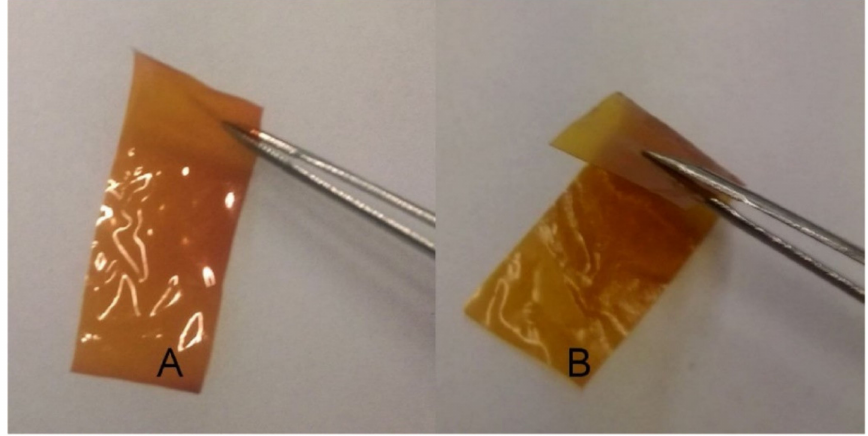
Figure 10. ( A ) HYH–Ag and ( B ) HYH–Ag–lecithin foils. Reproduced with permission [152]. Copyright Elsevier, 2016.